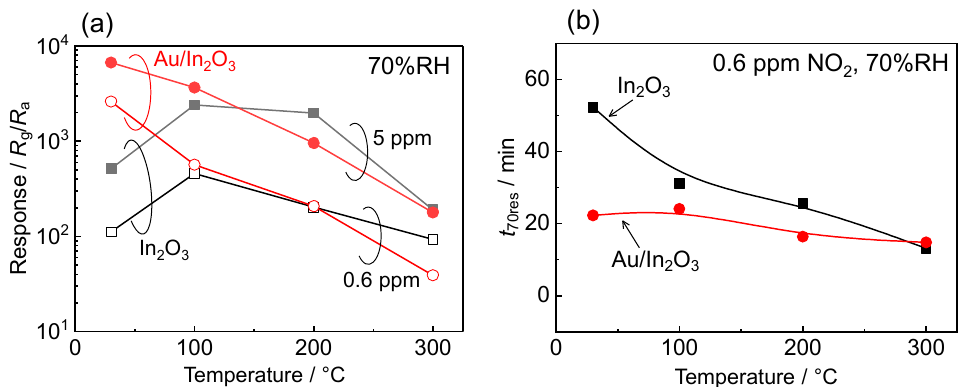
Figure 4. ( a ) Variations in response of the In 2 O 3 and Au / In 2 O 3 sensors to 0.6 and 5 ppm NO 2 and ( b ) variations in 70% response time ( t 70res ) of the In 2 O 3 and Au / In 2 O 3 sensors to 0.6 ppm NO 2 in wet air (70%RH at 25 ◦ C) with operating temperature.